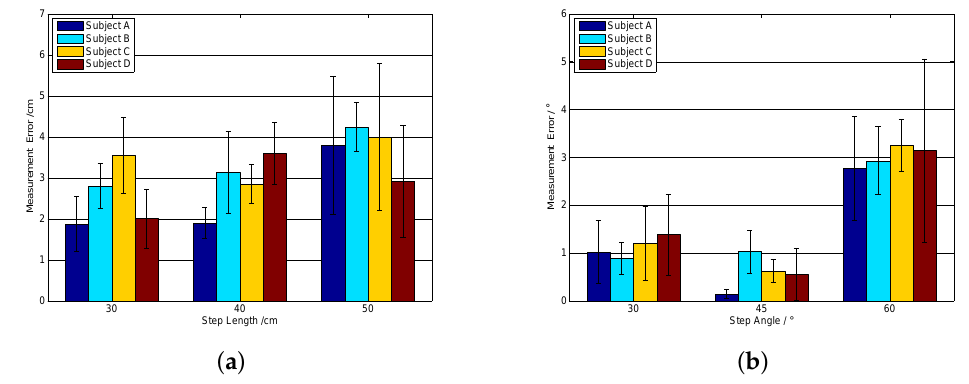
Figure 13. The setup of one-step experiments.